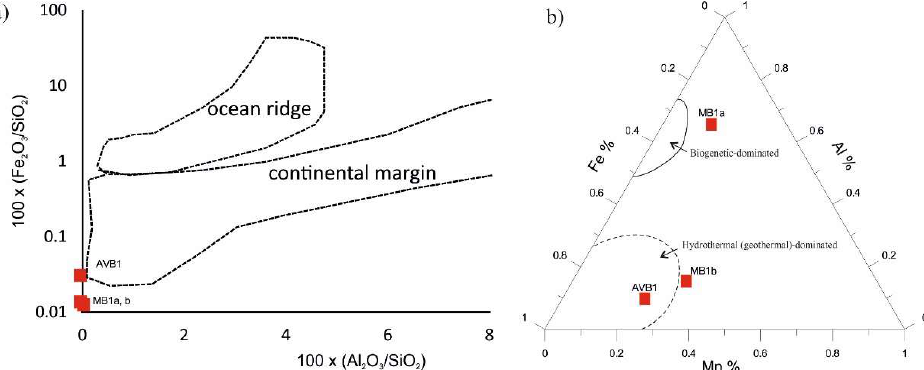
Figure 14. ( a ) Scatter plot of silicon, iron, aluminum oxides ratios (modified after Murray 1994 [40]; ( b ) Ternary plot of Al-Fe-Mn % in the studied samples (modified after Adachi et al. [41]).